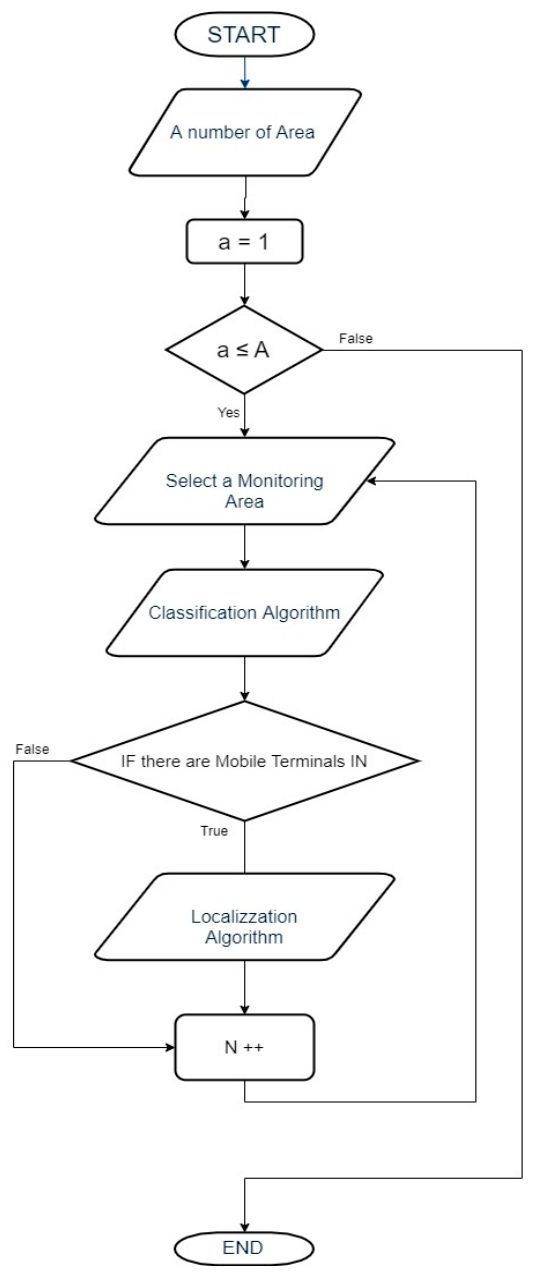
Figure 12. Flowchart of the proposed technique.